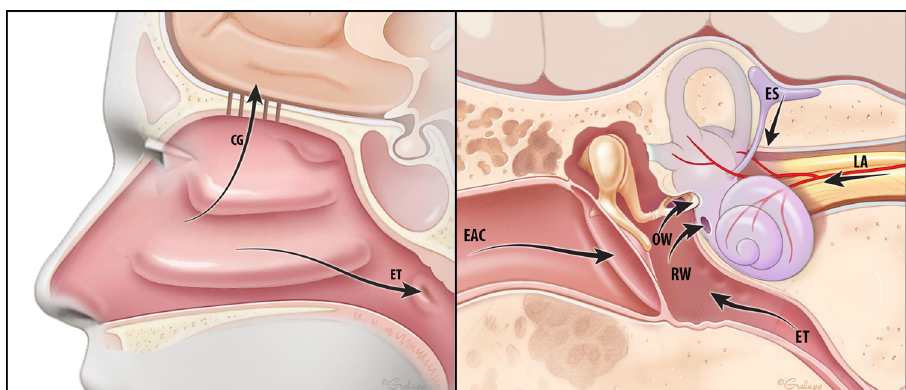
Fig. 7 Potential paths for SARS-CoV-2 entry into the inner ear. Arrows indicate potential paths via the nose and olfactory foramina (OF) into the central nervous system; via the endolymphatic sac (ES); via labyrinthine artery (LA) to ultimately reach stria vascularis; via round window (RW) and oval window (OW) membranes which the virus could reach through the Eustachian tube (ET) or external auditory canal (EAC), middle ear and mastoid. The diagram within this fi gure was drawn by Chris Gralapp and is being reproduced